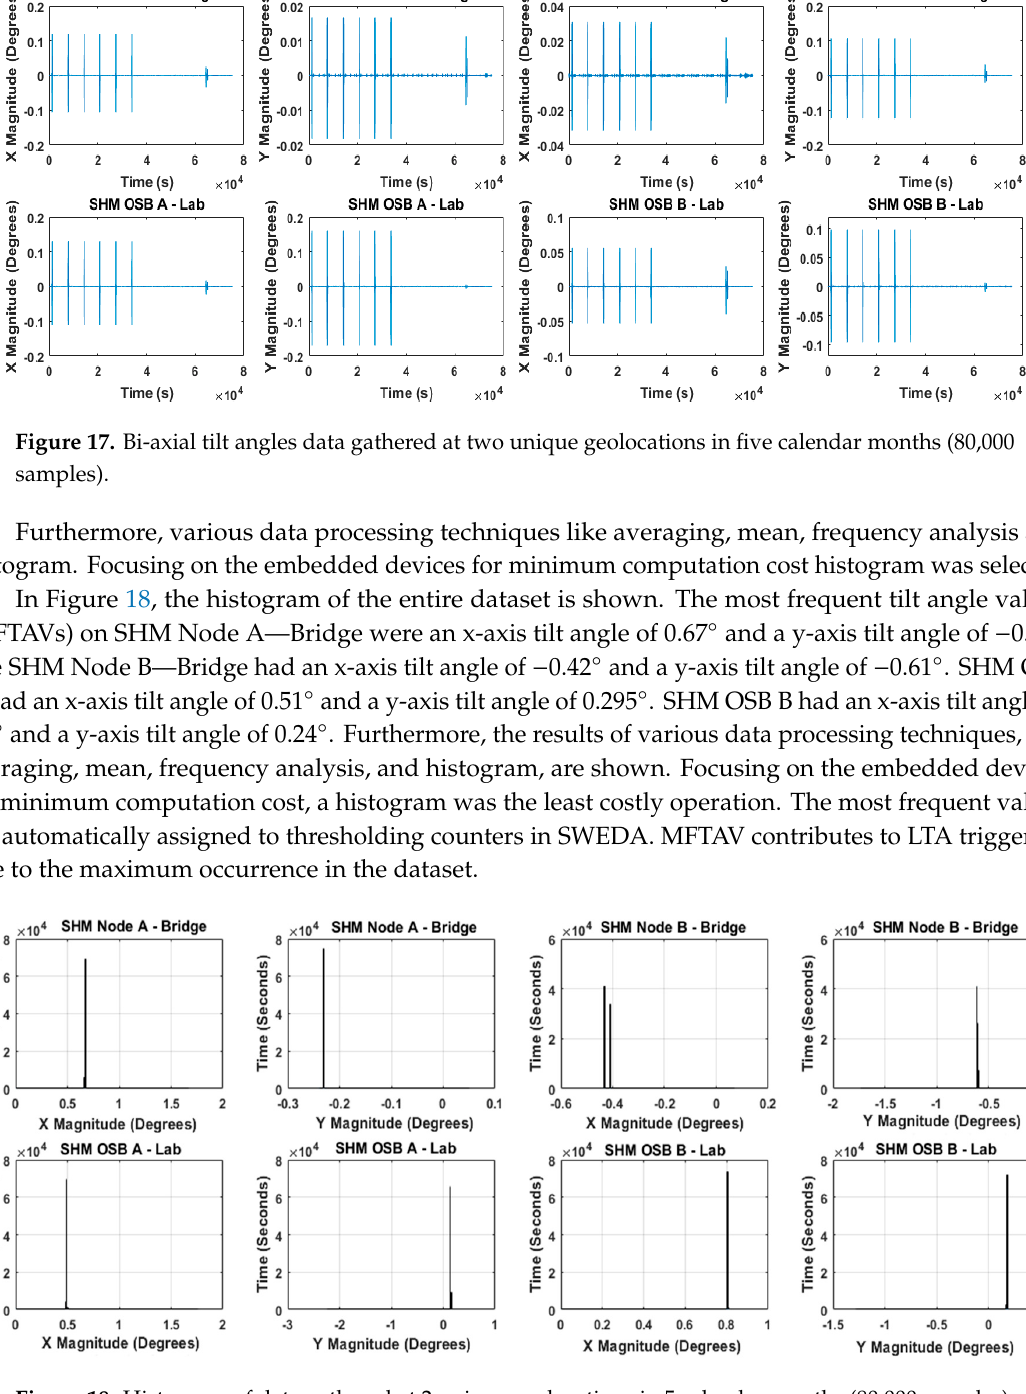
Figure 18. Histogram of data gathered at 2 unique geolocations in 5 calendar months (80,000